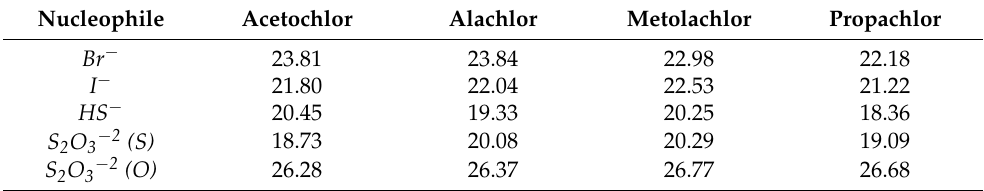
Table 1. Activation free energy in kcal/mol of the S N 2 reaction of chloroacetanilides in water.